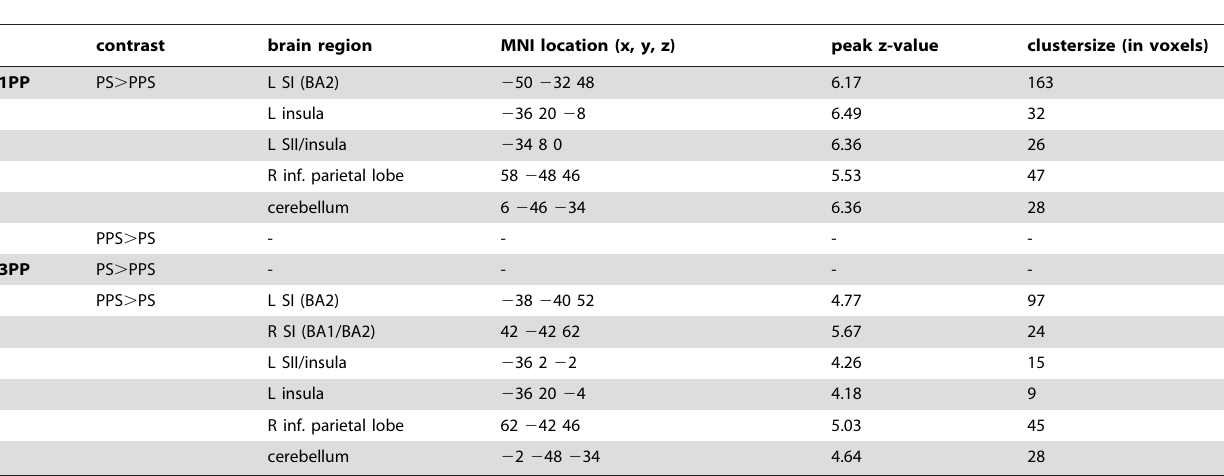
Table 1. Results of random effects analysis (p , 0.05, FWE corrected, L=left hemisphere, R=right hemisphere, masked with real touch . baseline).